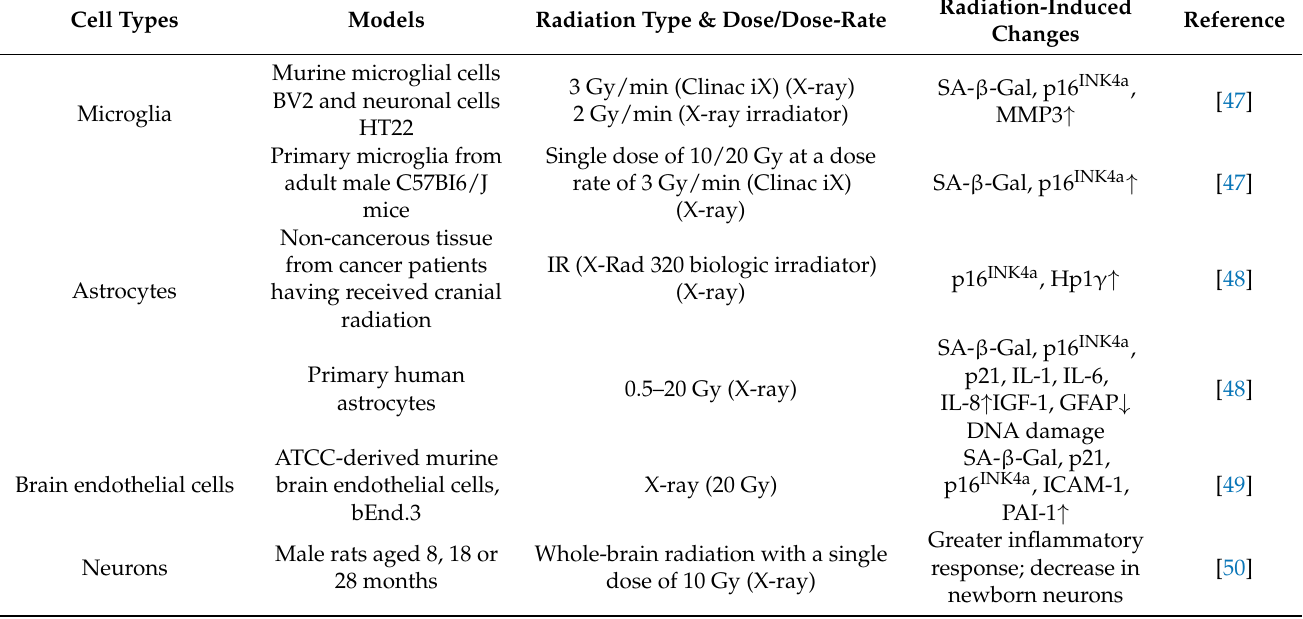
Table 2. Radiation-induced senescence in different cell